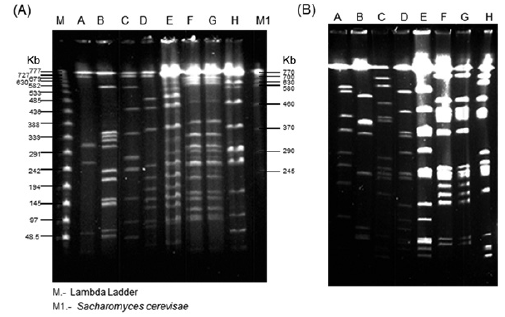
Fig. 1. PFGE for 8 Psm strains with Pac I (A) and Pme I (B), electrophoresis conditions are described in materials and methods section. A. ICMP921; B. GSPB2146;